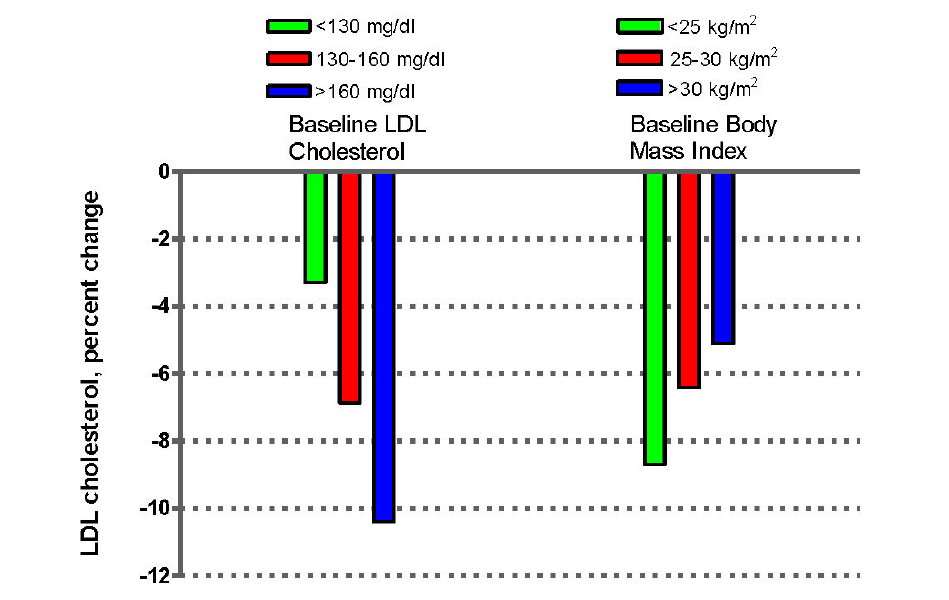
Figure 3 . LDL-cholesterol response to nut feeding by baseline LDL-cholesterol level and BMI. Data from a pooled study of 25 nut feeding trials (adapted from ref.